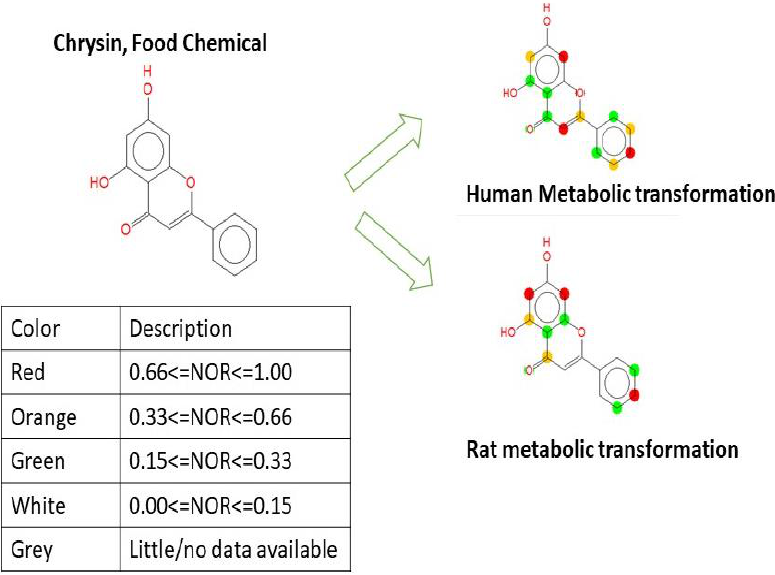
Figure 6 . Metabolic transformation of natural compound chrysin. Figure 6. Metabolic transformation of natural compound